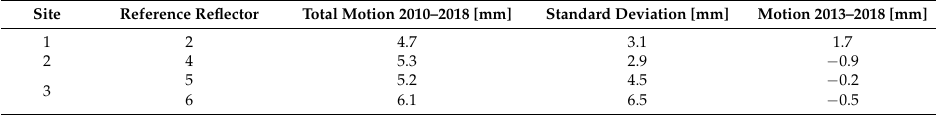
Table 4. Measured displacement of Reflector 1 at Site 1, referenced to the four reference reflectors.